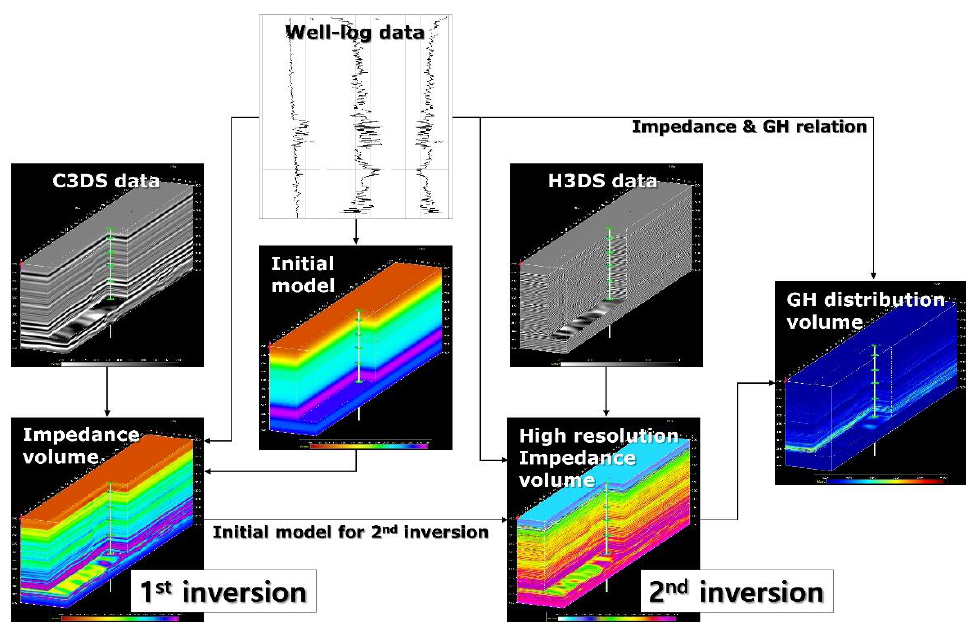
Figure 4. Data analysis workflow. The GH distribution volume was estimated from two seismic inversions with two different 3D seismic datasets and UBGH2-6 well-log. inversions with two different 3D seismic datasets and UBGH2-6